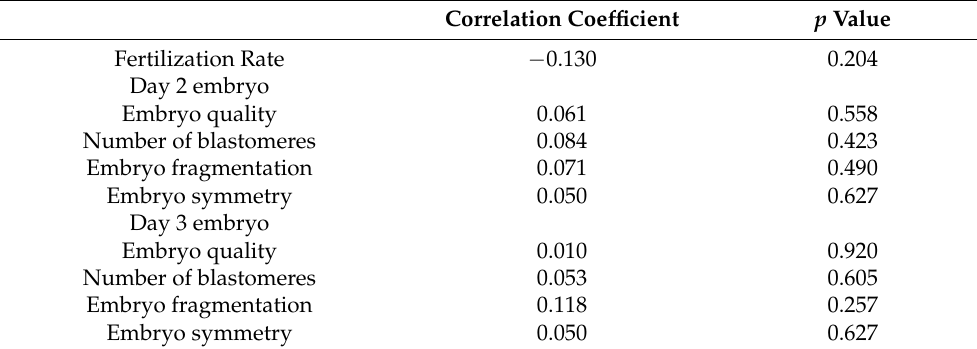
Table 3. Correlations between PRR-positive sperm cells and fertilization rate and embryo quality.